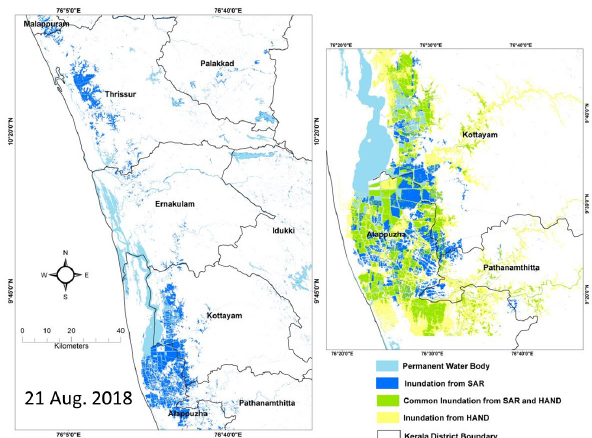
Figure 12. SAR based & ALOS- 30 m DEM + HAND based flood inundation maps for